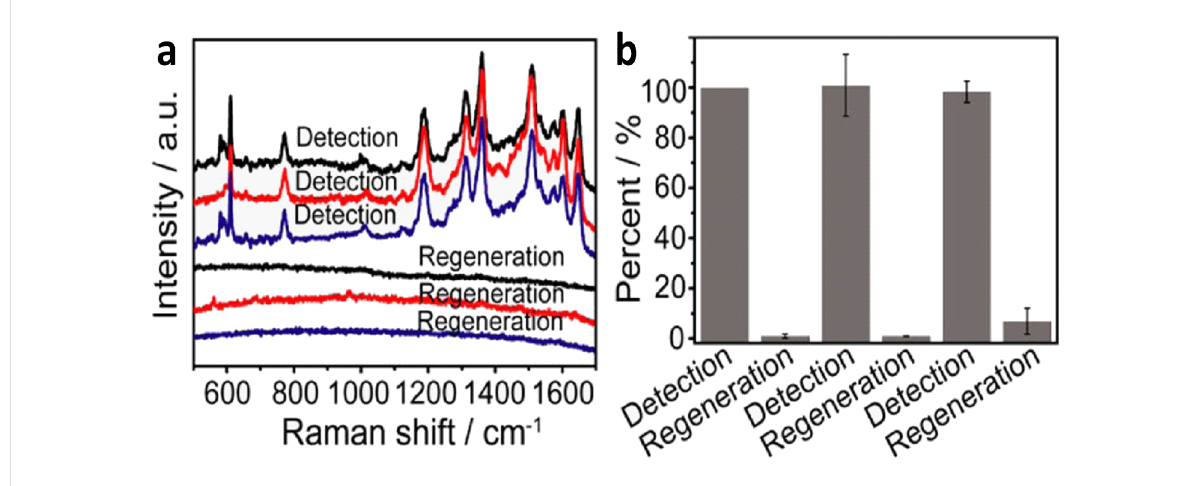
Figure 5: Recyclability demonstrated for an Au–ZnO substrate. SERS detection (a) of rhodamine 6G and regeneration of the substrate. Each coloured line represents a cycle of detection and photocatalytic cleaning of the substrate. (b) Percentage of degradation and recovery calculated for the 1360 cm − 1 Raman band of rhodamine 6G. Adapted with permission from [32] Copyright (2016) American Chemical Society. This content is not subject to CC BY 4.0.